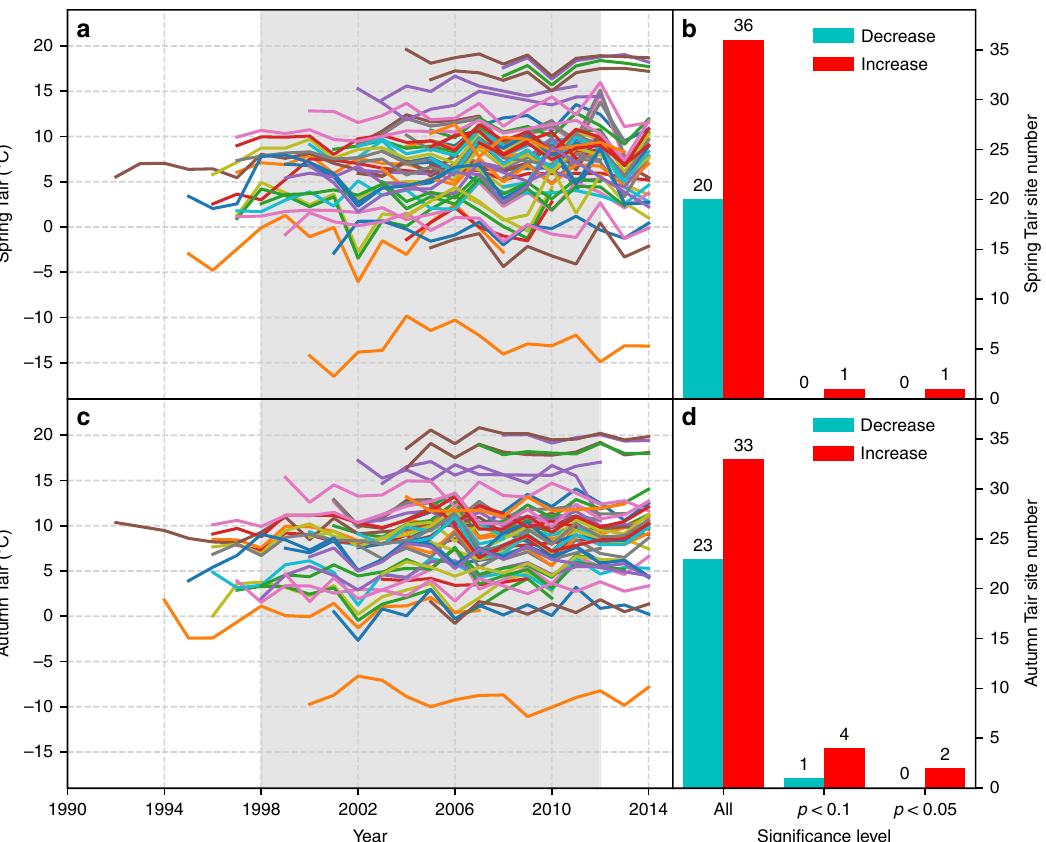
Fig. 4 Spring and autumn temperature trends at 56 FLUXNET sites. The left plots are the spaghetti plots of spring ( a ) and autumn ( b ) temperature. The right plots are the number of sites with different signi fi cance level for spring temperature ( c ) and autumn temperature ( d ). All stands for the total number of sites with positive slope (or negative slope) regardless of signi fi cance level. p < 0.1 stands for the number of sites with positive slope (or negative slope) that was signi fi cant at p < 0.1. p < 0.05 stands for the number of sites with positive slope (or negative slope) that was signi fi cant at p < 0.05. The light gray background indicates the warming